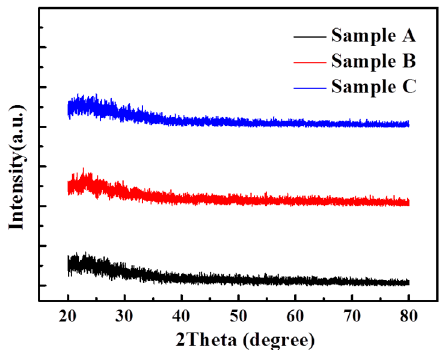
Figure 2. XRD spectra of three IGO thin-film samples exhibited no peak, indicating that all samples were in an amorphous phase.